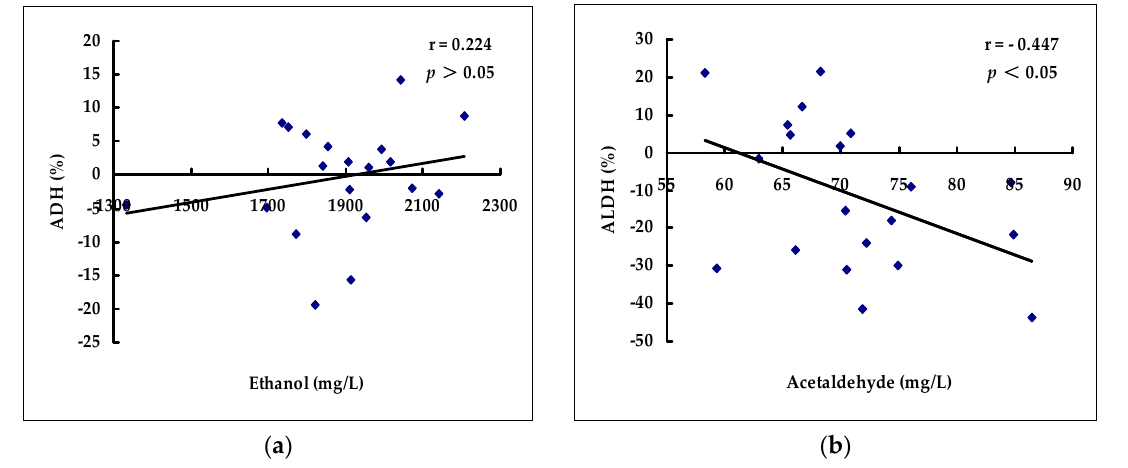
Figure 1. The correlations between the activity of ADH in liver and the content of ethanol in blood ( a ) as well as the activity of ALDH in liver and the content of acetaldehyde in blood ( b ) as influenced by the 20 selected beverages.